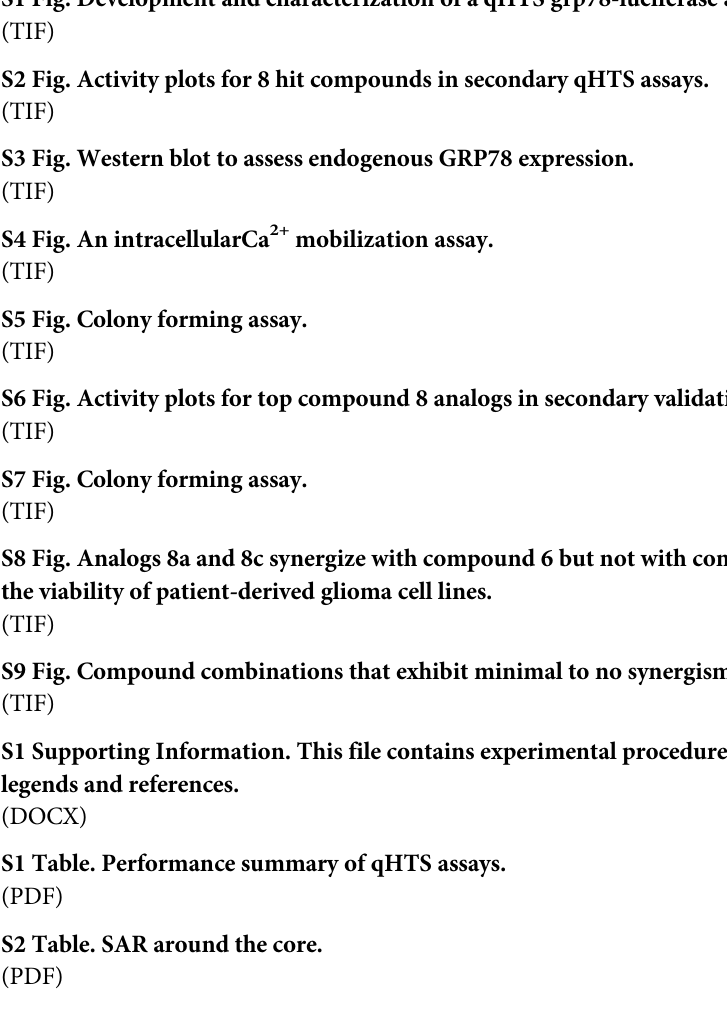
S1 Table. Performance summary of qHTS